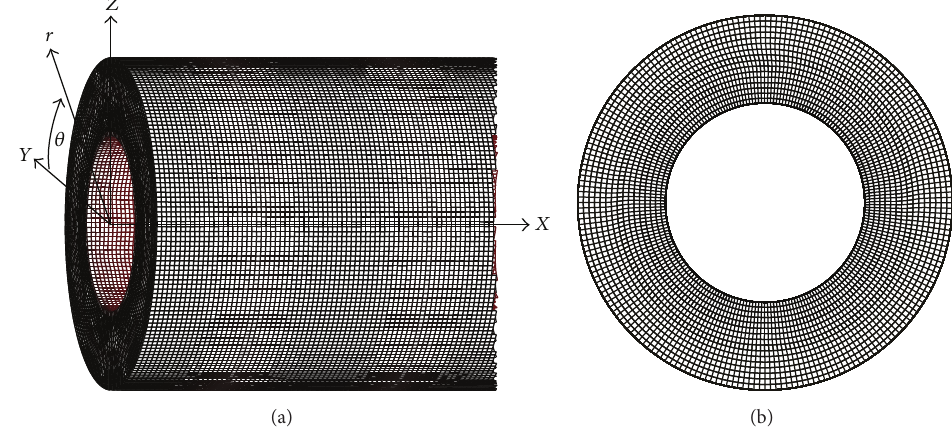
Figure 1: (a) Tetrahedral computational mesh structure and (b) computational mesh detail at the end-wall. One mesh point every 10 has been plotted radially, for